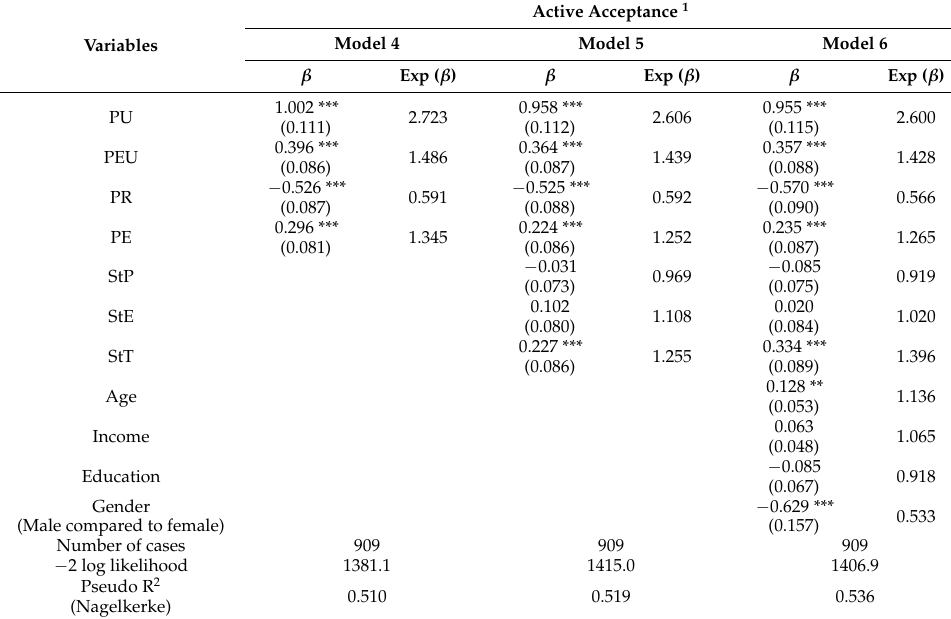
Table 3. Results for ordered logistic model (active